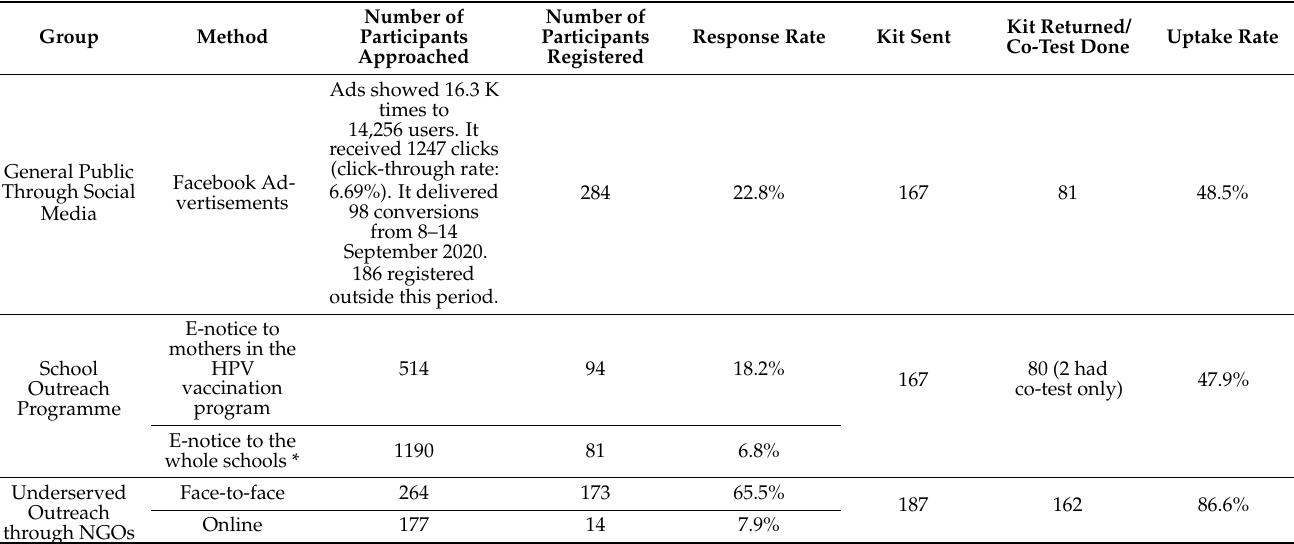
Table 2. Participation and uptake rate of HPV